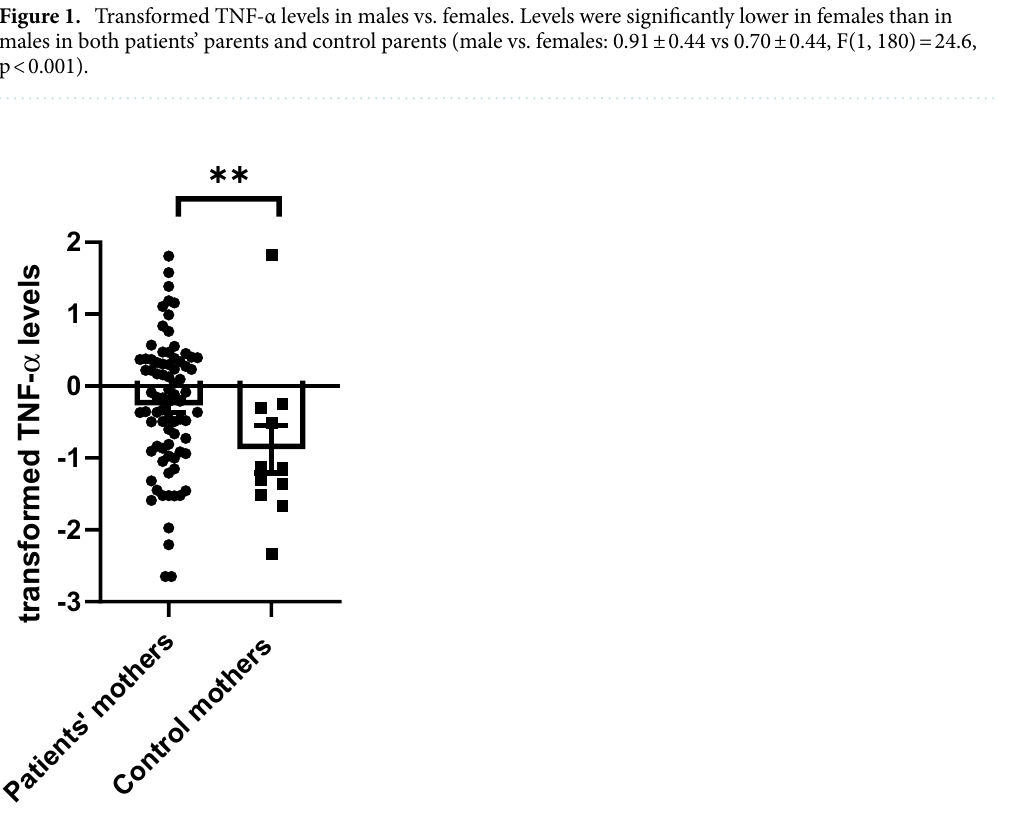
Figure 2. Transformed TNF-α levels in the patients’ group vs. the control group. Higher transformed TNF-α levels were found in the patients’ mothers vs. the control mothers (Mann–Whitney: p = 0.009, adj. p value =